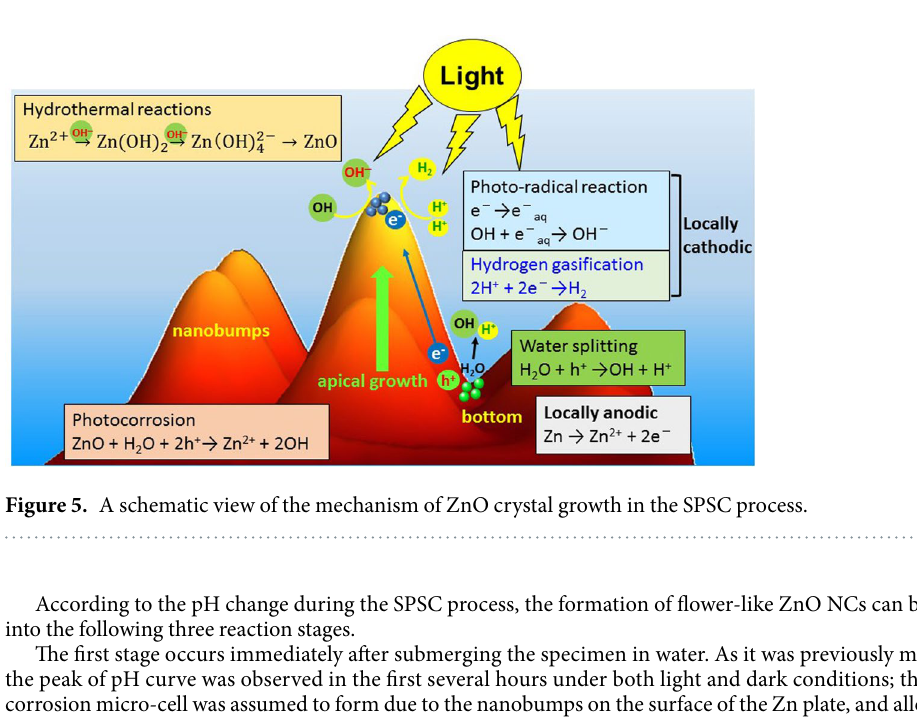
Figure 4. TEM images, SAED pattern, and EDS profile of the NRs after 24 h of UV irradiation on a copper mesh. ( a ), ( b ), and ( c ) show the TEM micrographs. ( d ) SAED pattern of P1 position in ( c ). ( e ) EDS profile of the ZnO NRs, and the inset shows atom ratio of O and Zn.